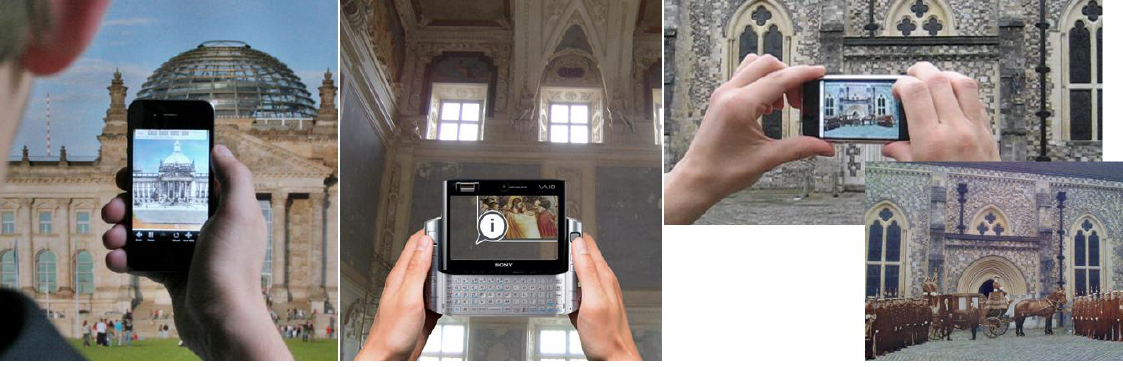
Figure 4. Three examples of on-site mobile Augmented Reality (AR) Cultural Heritage